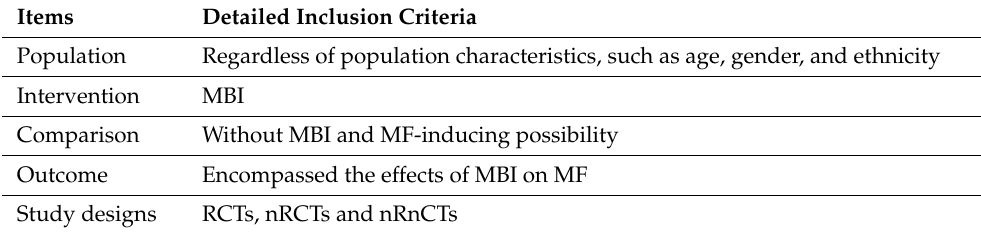
Table 1. Inclusion criteria according to the PICOS conditions.